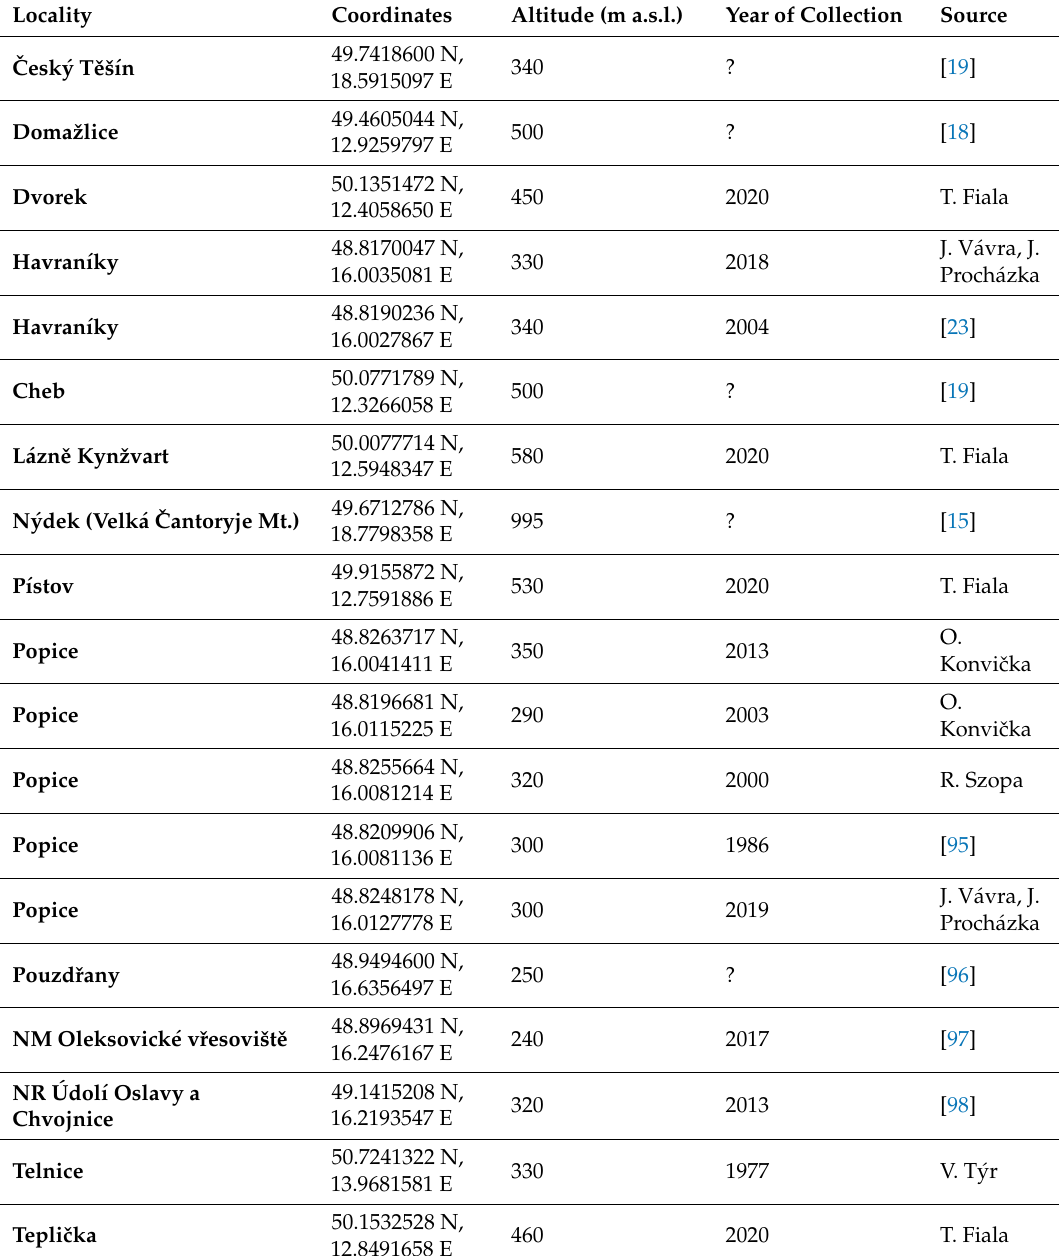
Table 2. Known localities of Phloeotribus rhododactylus in the Czech Republic. Data were excerpted from the literature, as well from private collections and from unpublished entomological reports (NM—Natural Monument; NR—Natural Reserve). Collection of data by T. Fiala in 2020 is described in this